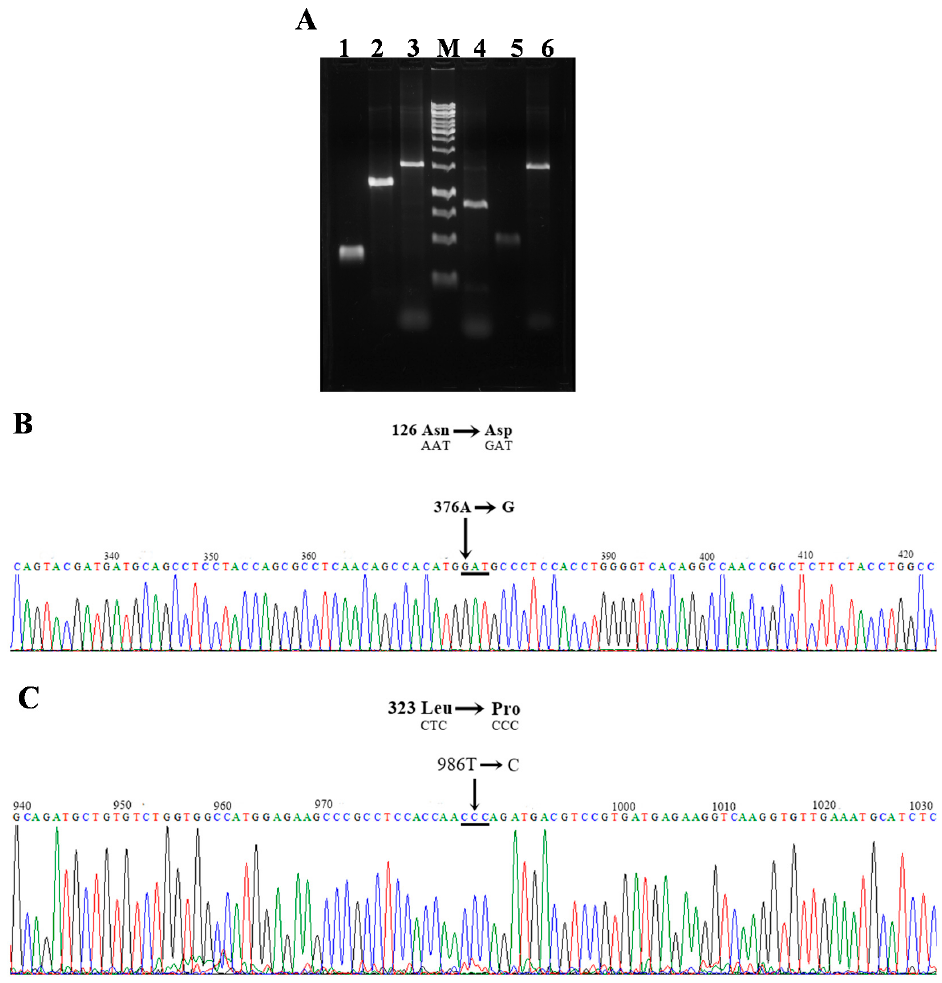
Figure 2. Construction of three clinical G6PD mutants. ( A ) The polymerase chain reaction (PCR) amplified product from the first and second round in agarose gel electrophoresis (1%). M: Marker O´GeneRuler 1 kb DNA ladder (Thermo Scientific). Lane 1, G6PD A+ fragment 1; lane 2, G6PD A+ fragment 2; lane 3, amplification of the full-length G6PD G6PD A+; lane 4, G6PD Nefza fragment 1; lane 5, G6PD Nefza fragment 2; lane 6, amplification of the full-length G6PD Nefza; ( B ) Electropherogram of the single mutant G6PD A+ (A376G, Asn → Asp); ( C ) Electropherogram of the single mutant G6PD Nefza (T968C, Leu → Pro). In all cases the mutations with corresponding nucleotide and amino acid substitutions are shown.